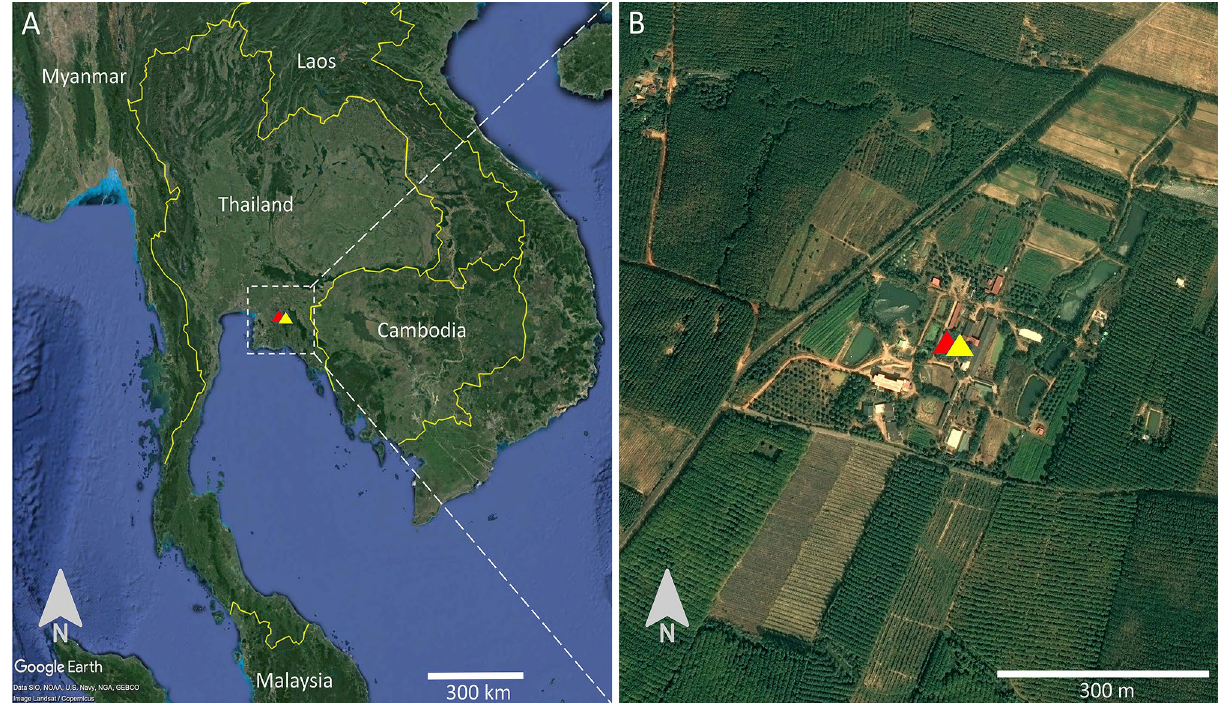
Figure 3. ( A ) Map depicting a buffalo farm in Chachoengsao for sample collection in Thailand. ( B ) The landscape of mosquito sampling sites in a buffalo farm in Chachoengsao. The images were obtained and modified from Google Earth Pro version 7.3.4.8248. The red triangle indicates blood sample collection sites, while the yellow triangle indicates mosquito sampling